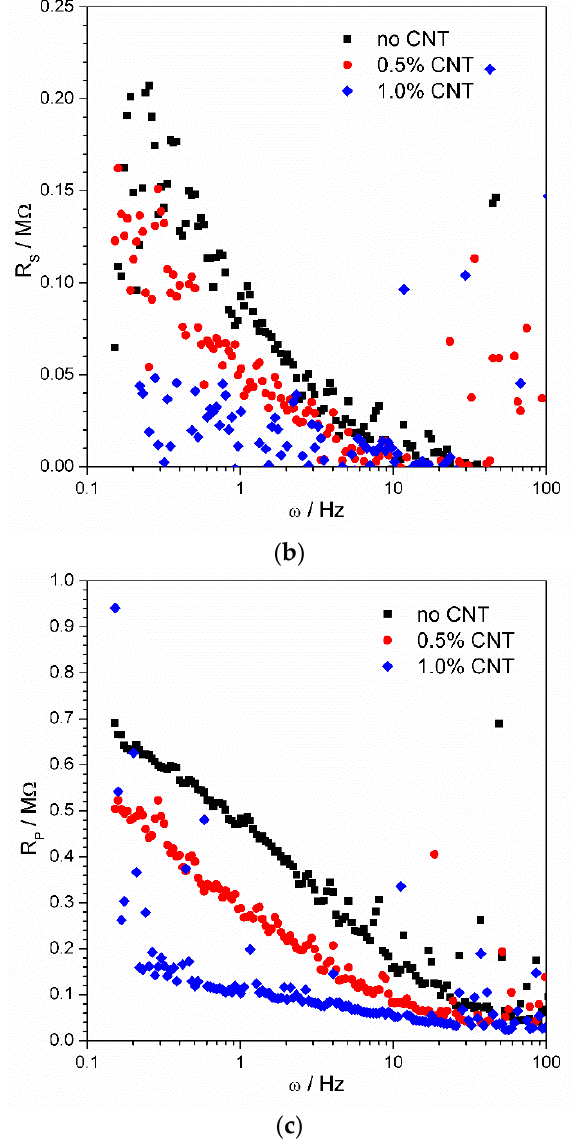
Figure 5. Calculated values of average capacitance C ( a ), series resistance R S ( b ), and parallel resistance R P ( c ) as a function of probing signal frequency.